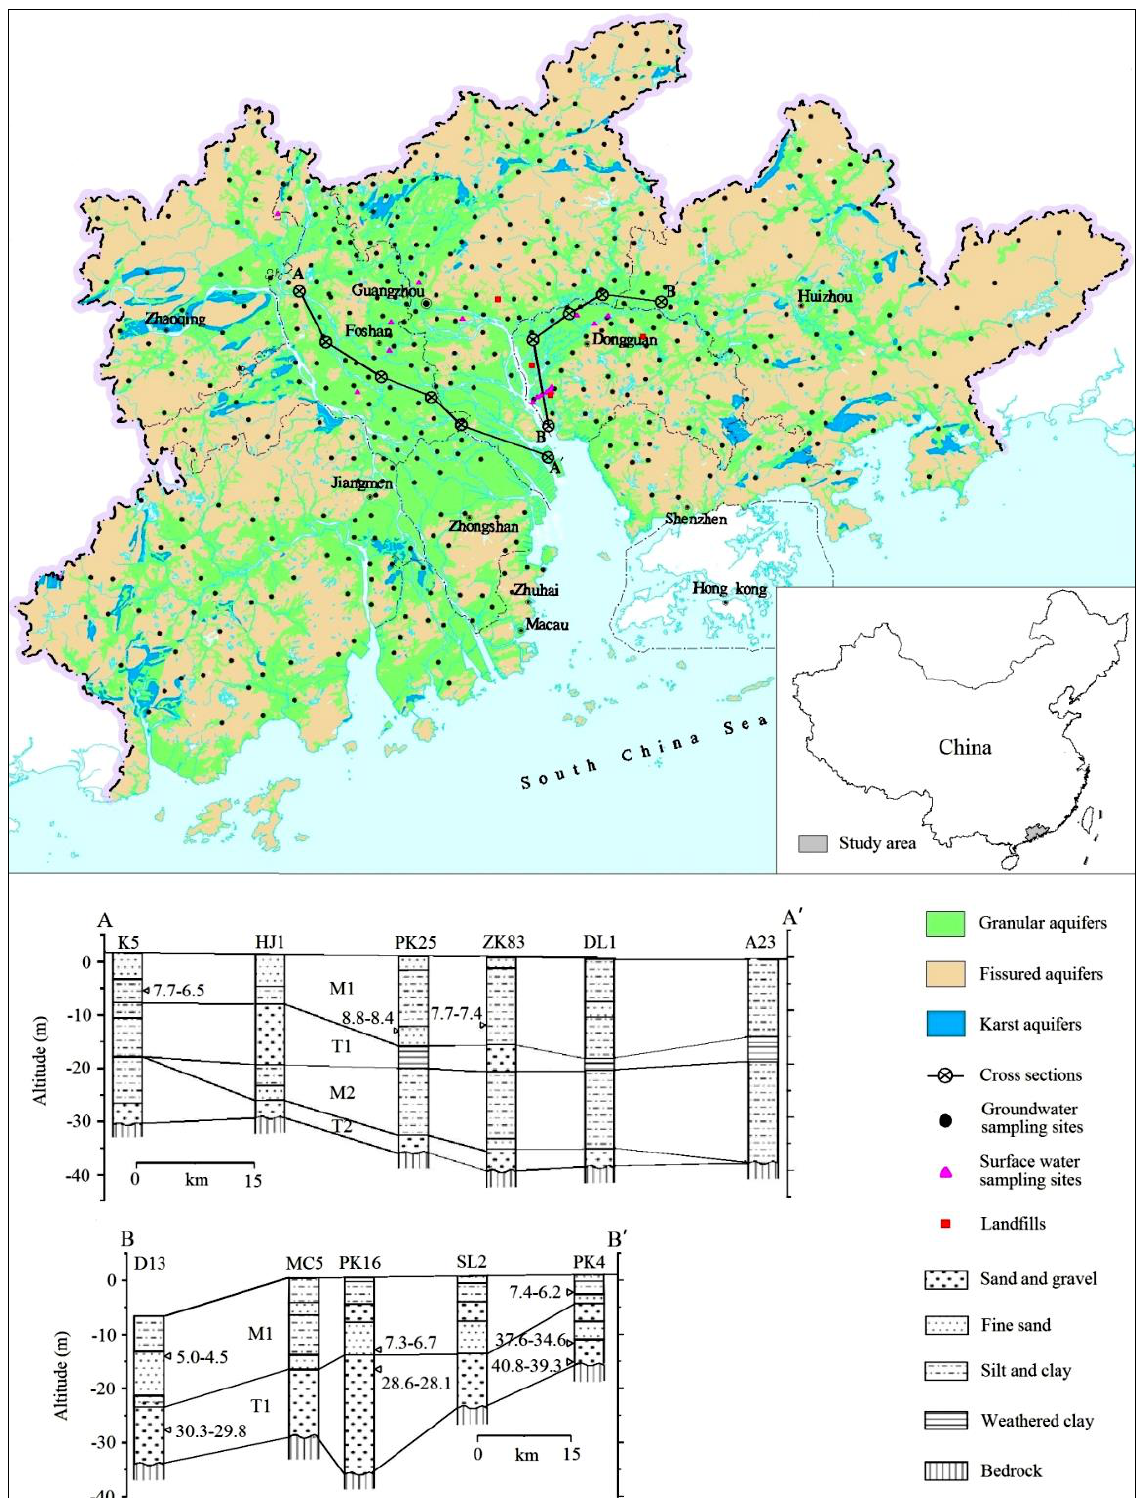
Figure 1. Hydrogeological setting and sampling sites in the Pearl River